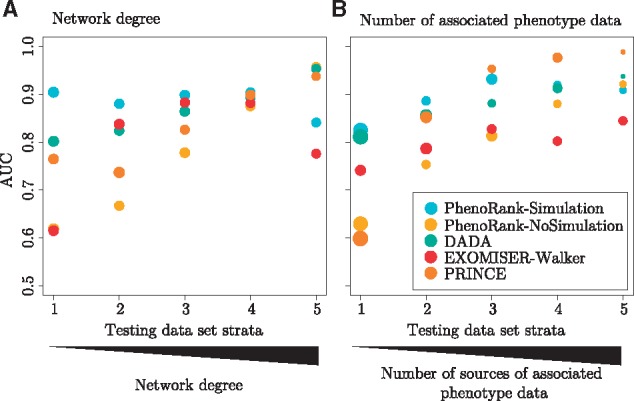
Method performance when applied to genes with different numbers of associated data.
For each method, the testing dataset of 2708 disease–gene associations was stratified
based on (A) the network degree of each gene and (B) the
number of sources of phenotype data associated with each gene, and leave-one-out
cross-validation completed. The size of each circle represents the numbers of
disease–gene associations in the testing dataset strata